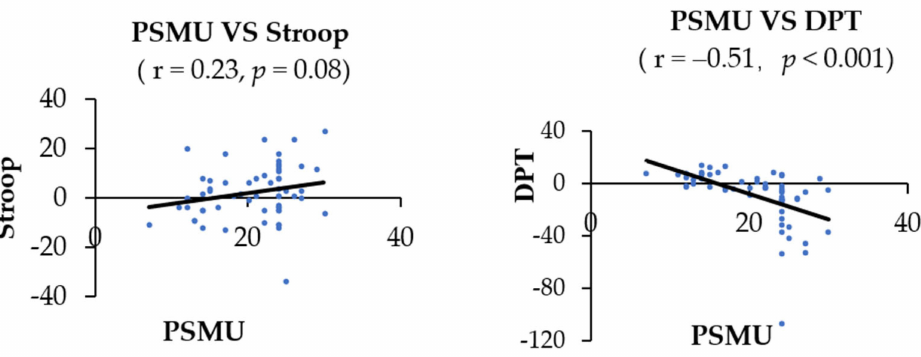
Figure 4. Correlation between PSMU and the index of AB in the addiction Stroop task and DPT. PSMU was negatively correlated with the index of AB in the addiction DPT (r = − 0.51, p <